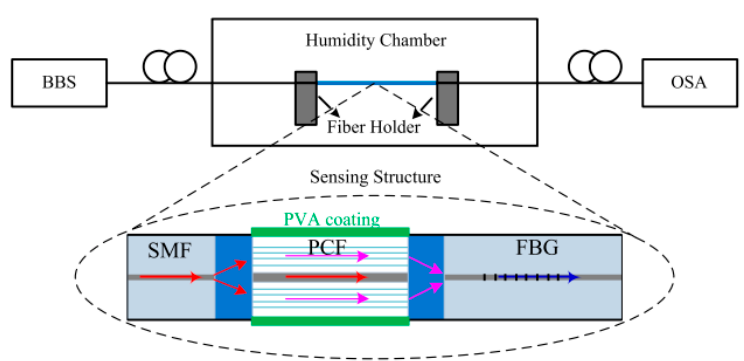
Figure 14. Schematic diagram of the experimental setup with the structure SMF-PCF-MZ interferometer and fiber bragg gratings (FBGs). Reprinted with permission from [100].